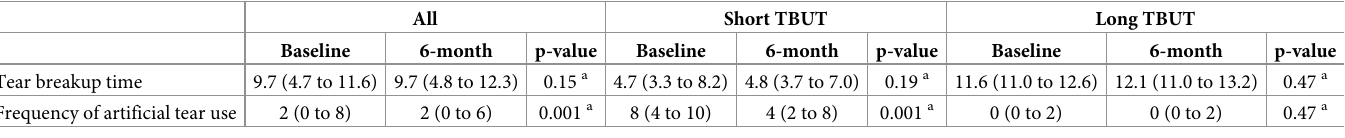
Table 2. Tear breakup time and frequency of artificial tears